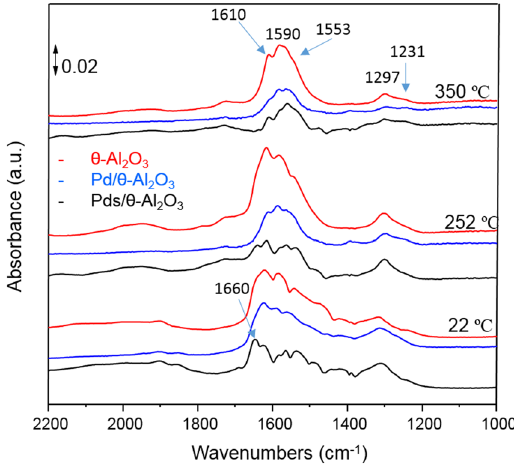
Figure 4. A comparison of in situ IR spectra during NO oxidation at 25, 250, and 350 °C on θ -alumina, Pds/ θ - alumina, and Pd/ θ -alumina.